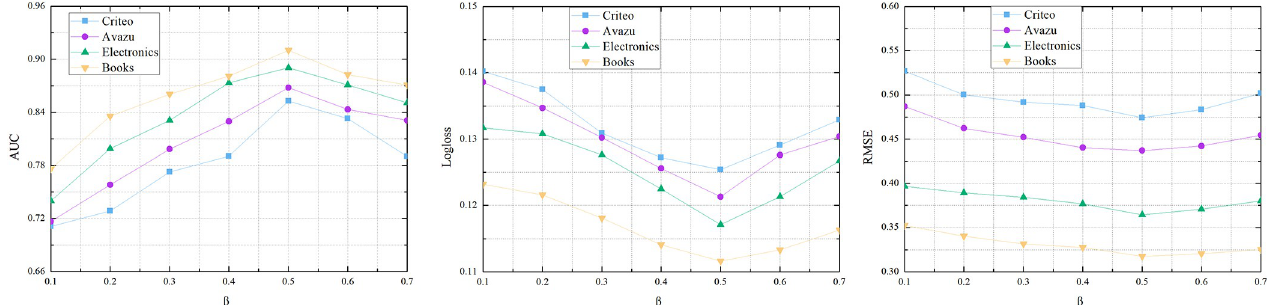
Fig 4. 4-1 Performance comparisons w.r.t. the dropout rate β . 4-2 Performance comparisons w.r.t. the dropout rate β . 4-3 Performance comparisons w.r.t. the dropout rate β